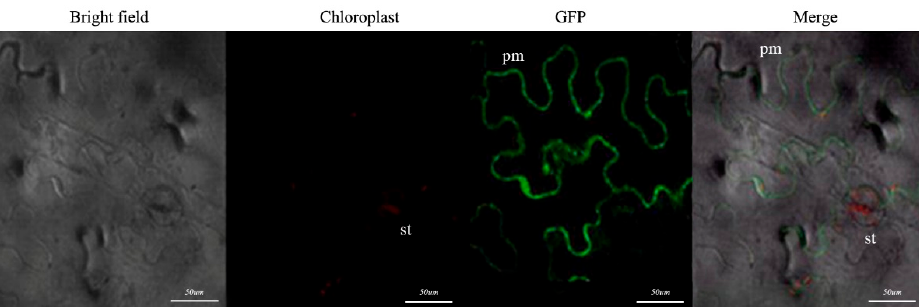
Figure 5. Relative expression of PsARRO − 1 in different parts of tree pony seedlings: different letters within the columns indicate significant differences ( p < 0.05) according to the Tukey test.